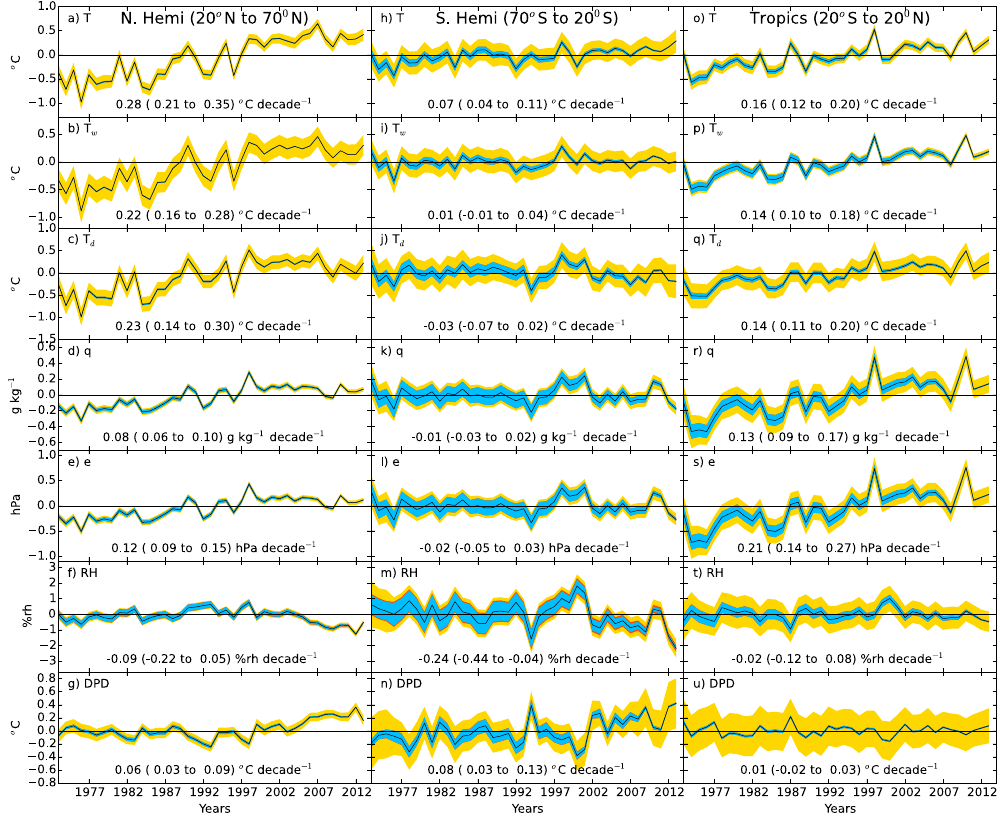
Figure 13. HadISDH.2.0.0 regional average time series for all variables for with combined uncertainties broken down by coverage (gold), temporal sampling (red) and station (gold). Decadal trends are shown with 5th to 95th percentile confidence intervals. (a, h, o) Temperature, (b, i, p) wet bulb temperature, (c, j, q) dew point temperature, (d, k, r) specific humidity, (e, l, s) vapour pressure, (f, m ,t) relative humidity, (g, n, u) dew point